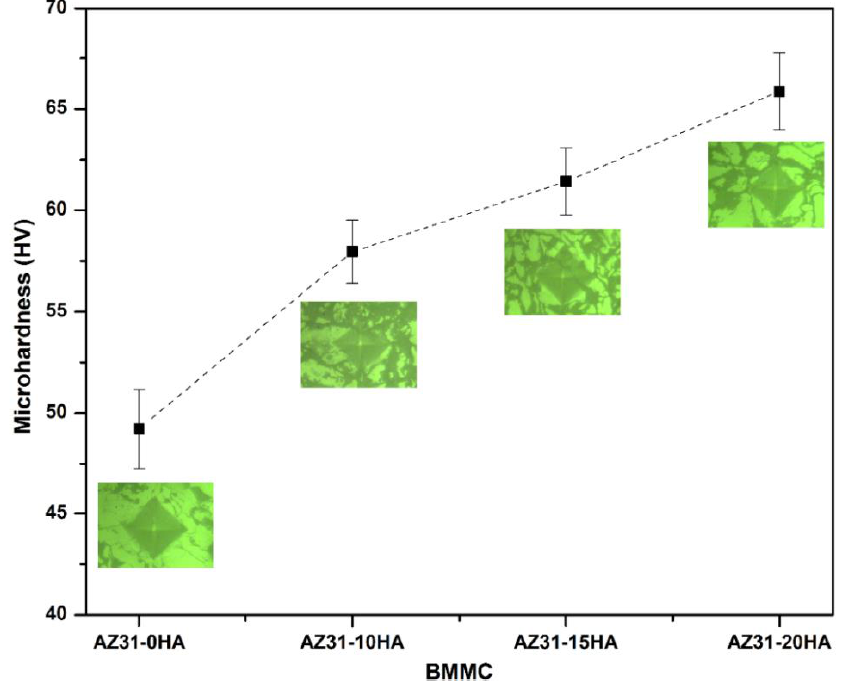
Figure 8. Typical microhardness variation of microwave-sintered AZ31-HA BMMCs; (Inset: optical image of indentation (scale: 200 µm)).